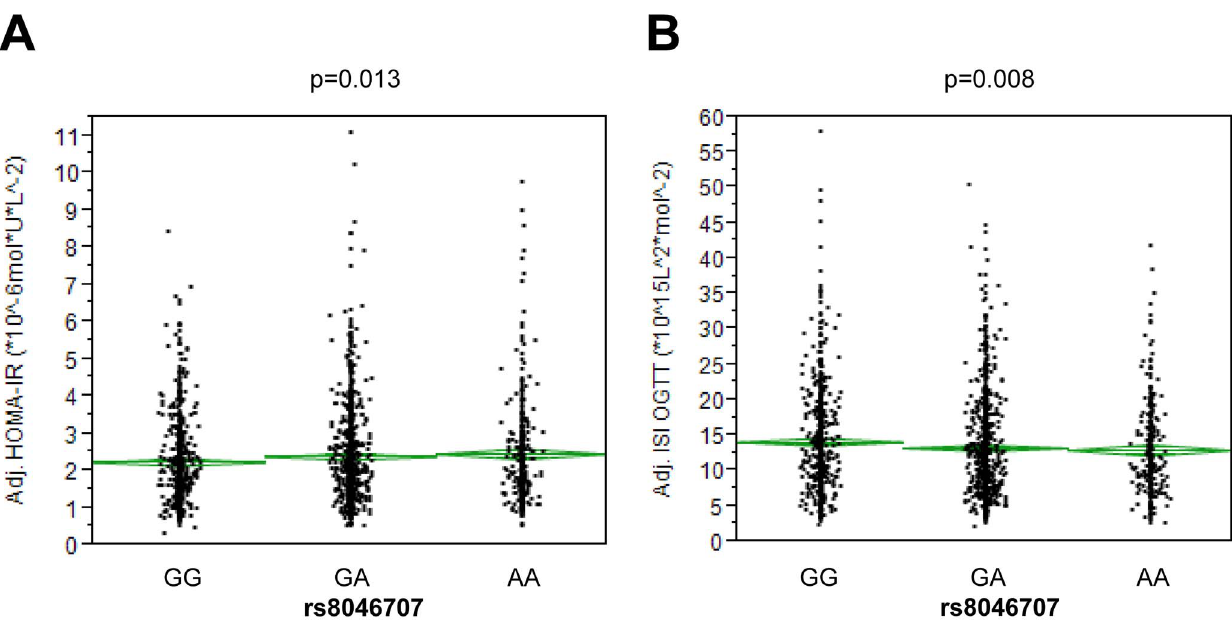
Figure 2. Association of SNP rs8046707 with HOMA-IR (A) and ISI OGTT (B). Data were adjusted for gender, age, and BMI. Diamonds represents means 6 SE. HOMA-IR – homeostasis model assessment of insulin resistance; ISI OGTT – oral glucose tolerance test-derived insulin sensitivity index. SNP – single nucleotide polymorphism.